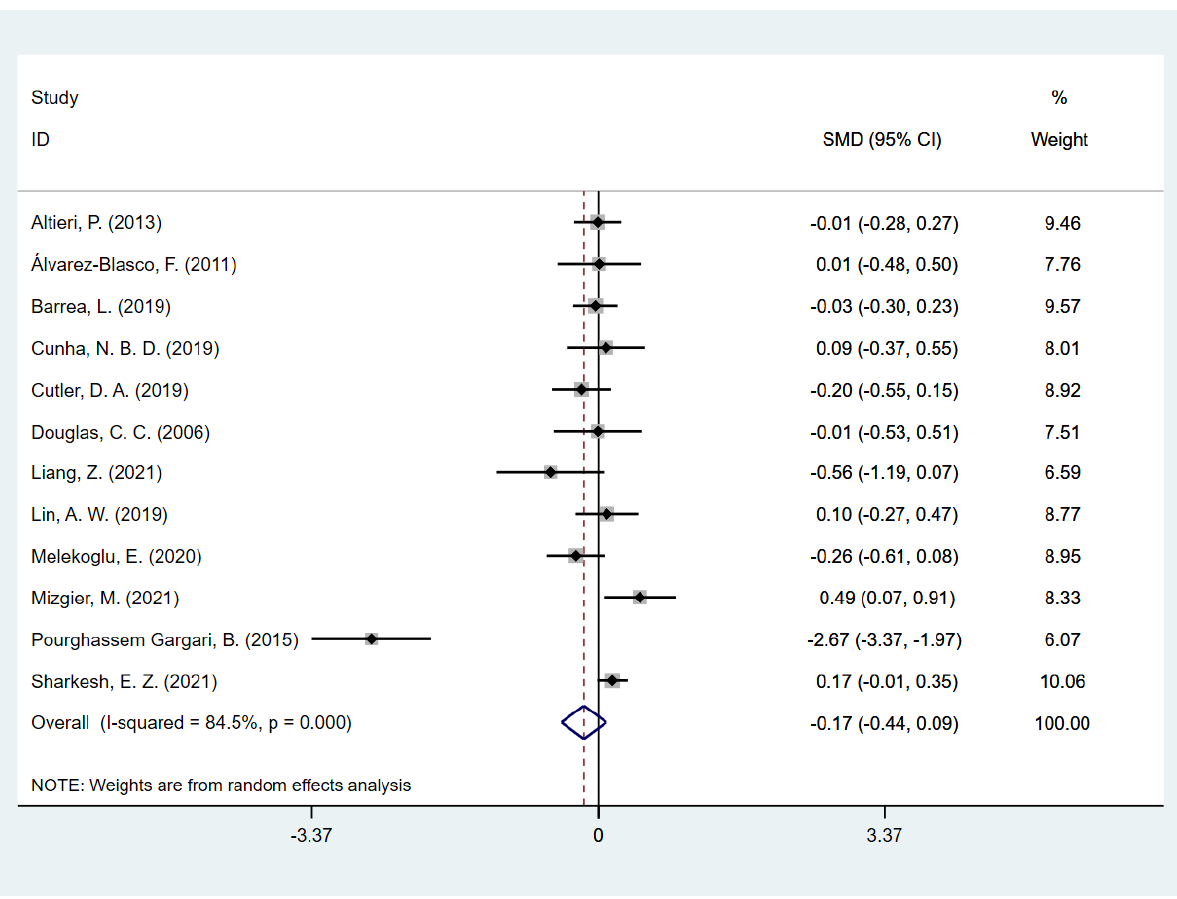
Figure 3. Meta-analysis of daily total energy intake on studies unadjusted for total energy intake [38−40,42−50].